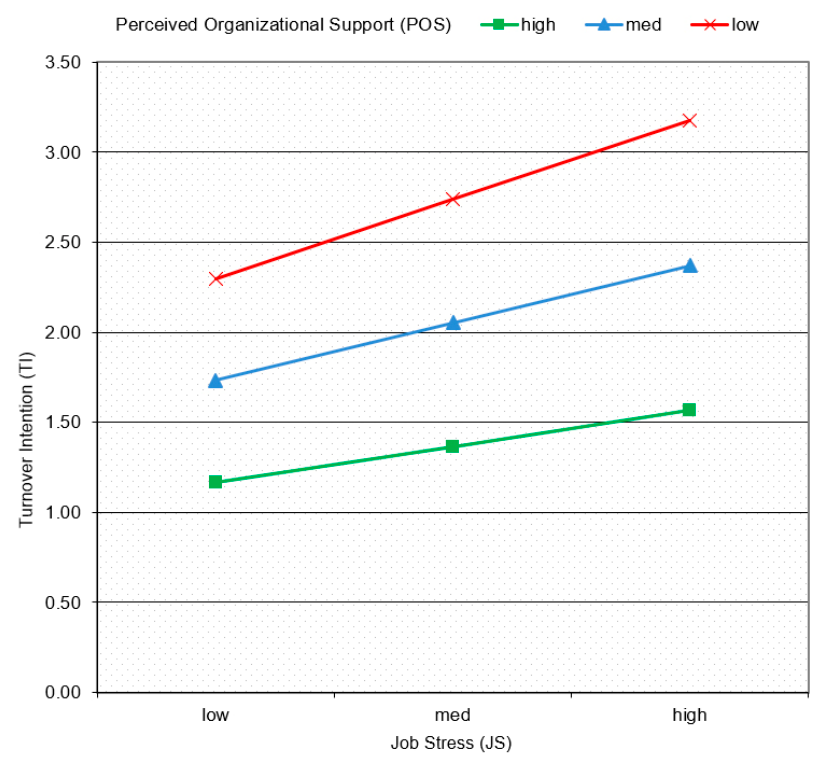
Figure 3. The interaction effects of POS on JS and TI.